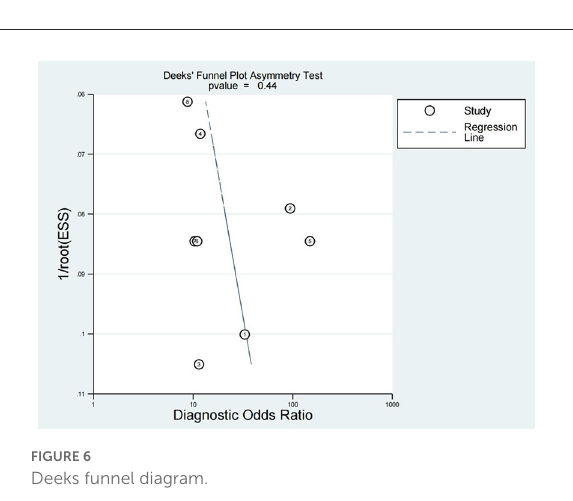
FIGURE6 Deeks funnel